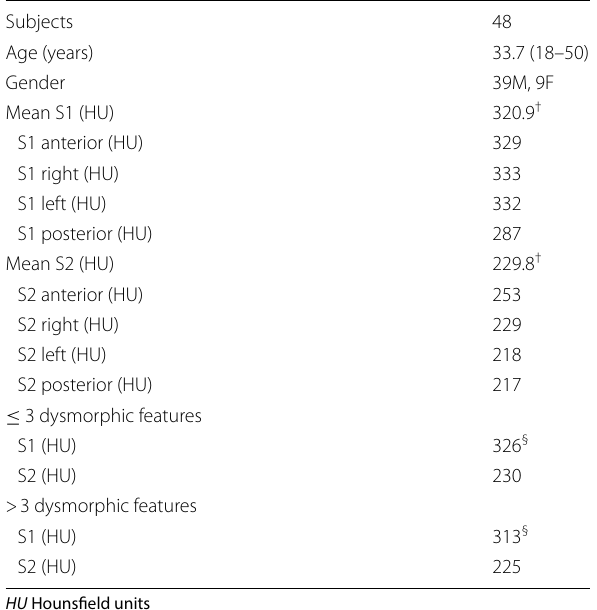
Table 1 Demographics and mean HU measures